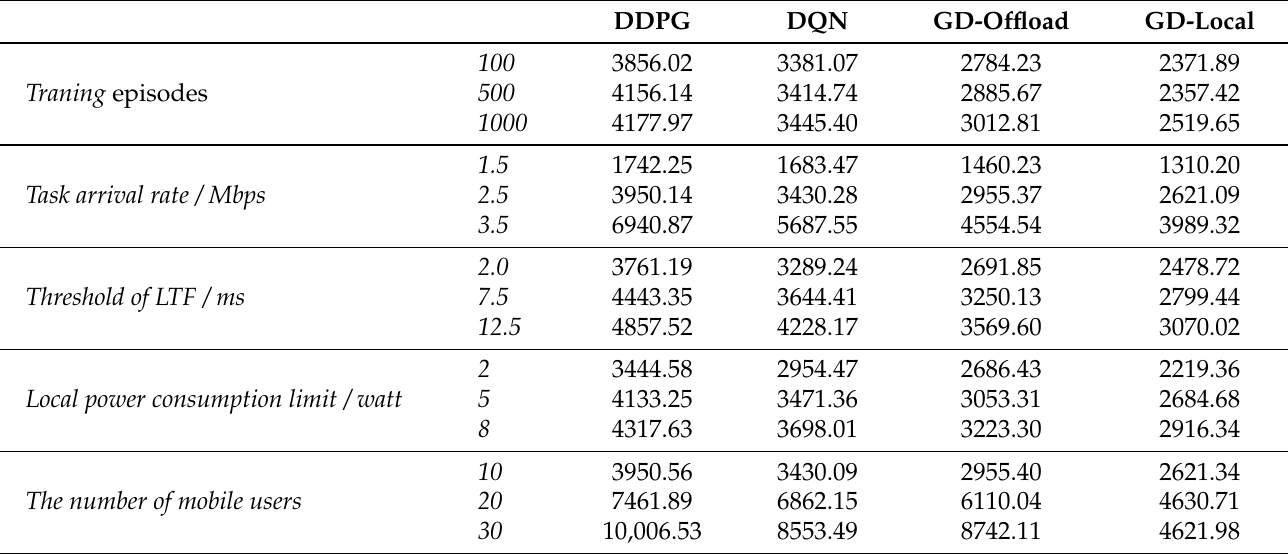
Table 4. Performance comparison in terms of average